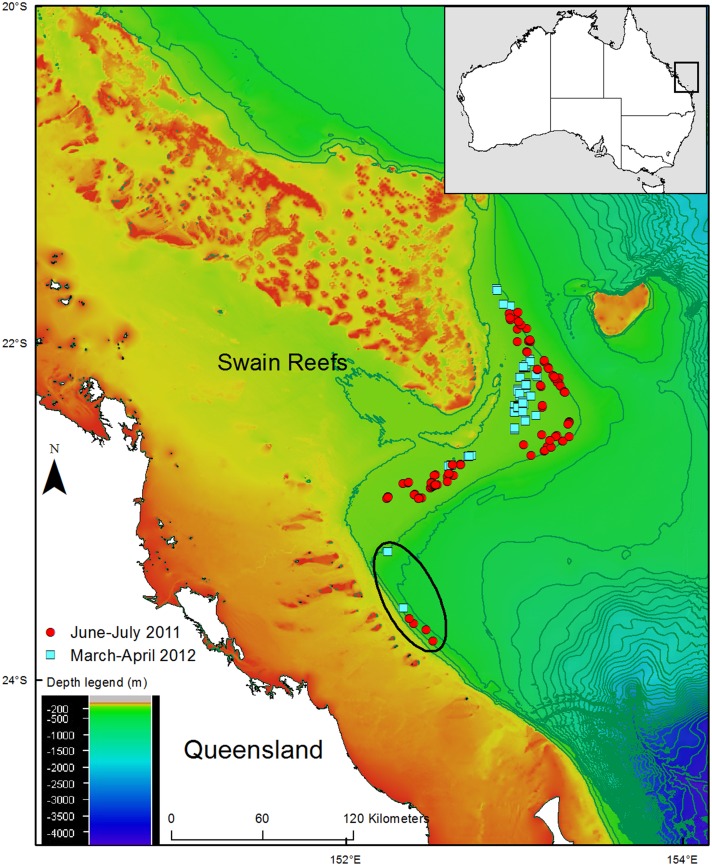
Sample locations for the chondrichthyan bycatch in the deepwater eastern king prawn fishery around Swain Reefs.The depth contours are at 100 metre intervals. The six shots south of main trawl ground are circled.